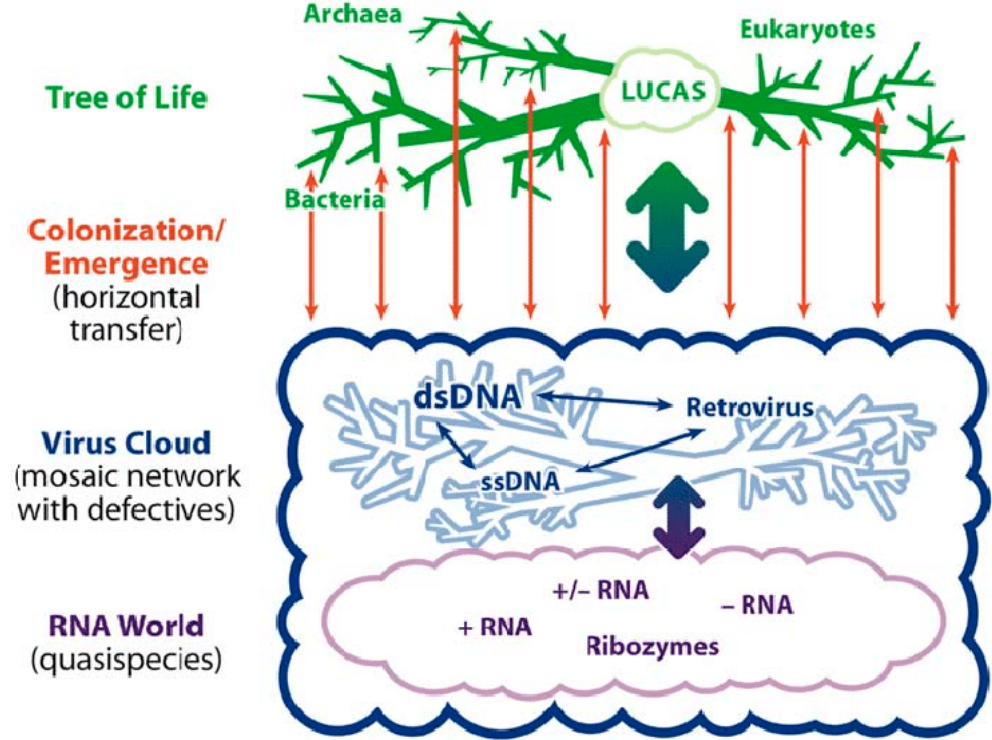
Figure 1. Representation of the relationship of the Tree of Life (green dendrogram) to the virosphere (blue cloud). The blue dendrogram represents species-specific persisting viruses. Reprinted from [21] with